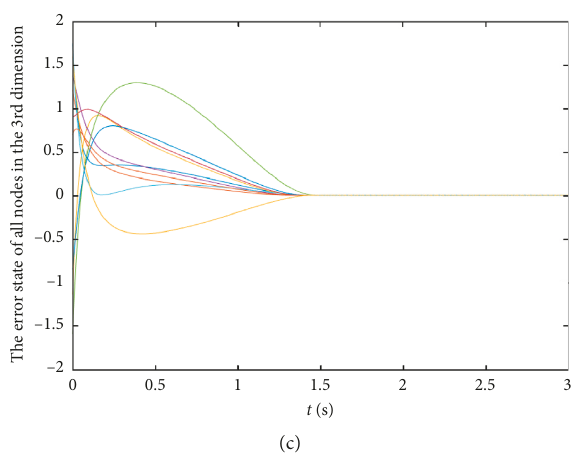
Figure 2: The error state of all nodes in different dimensions under the controller